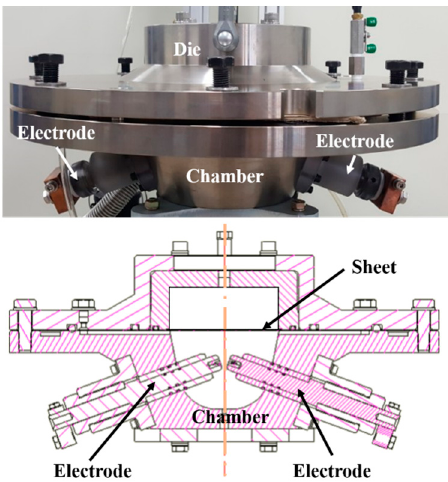
Figure 14. Experimental apparatus for electrohydraulic forming.